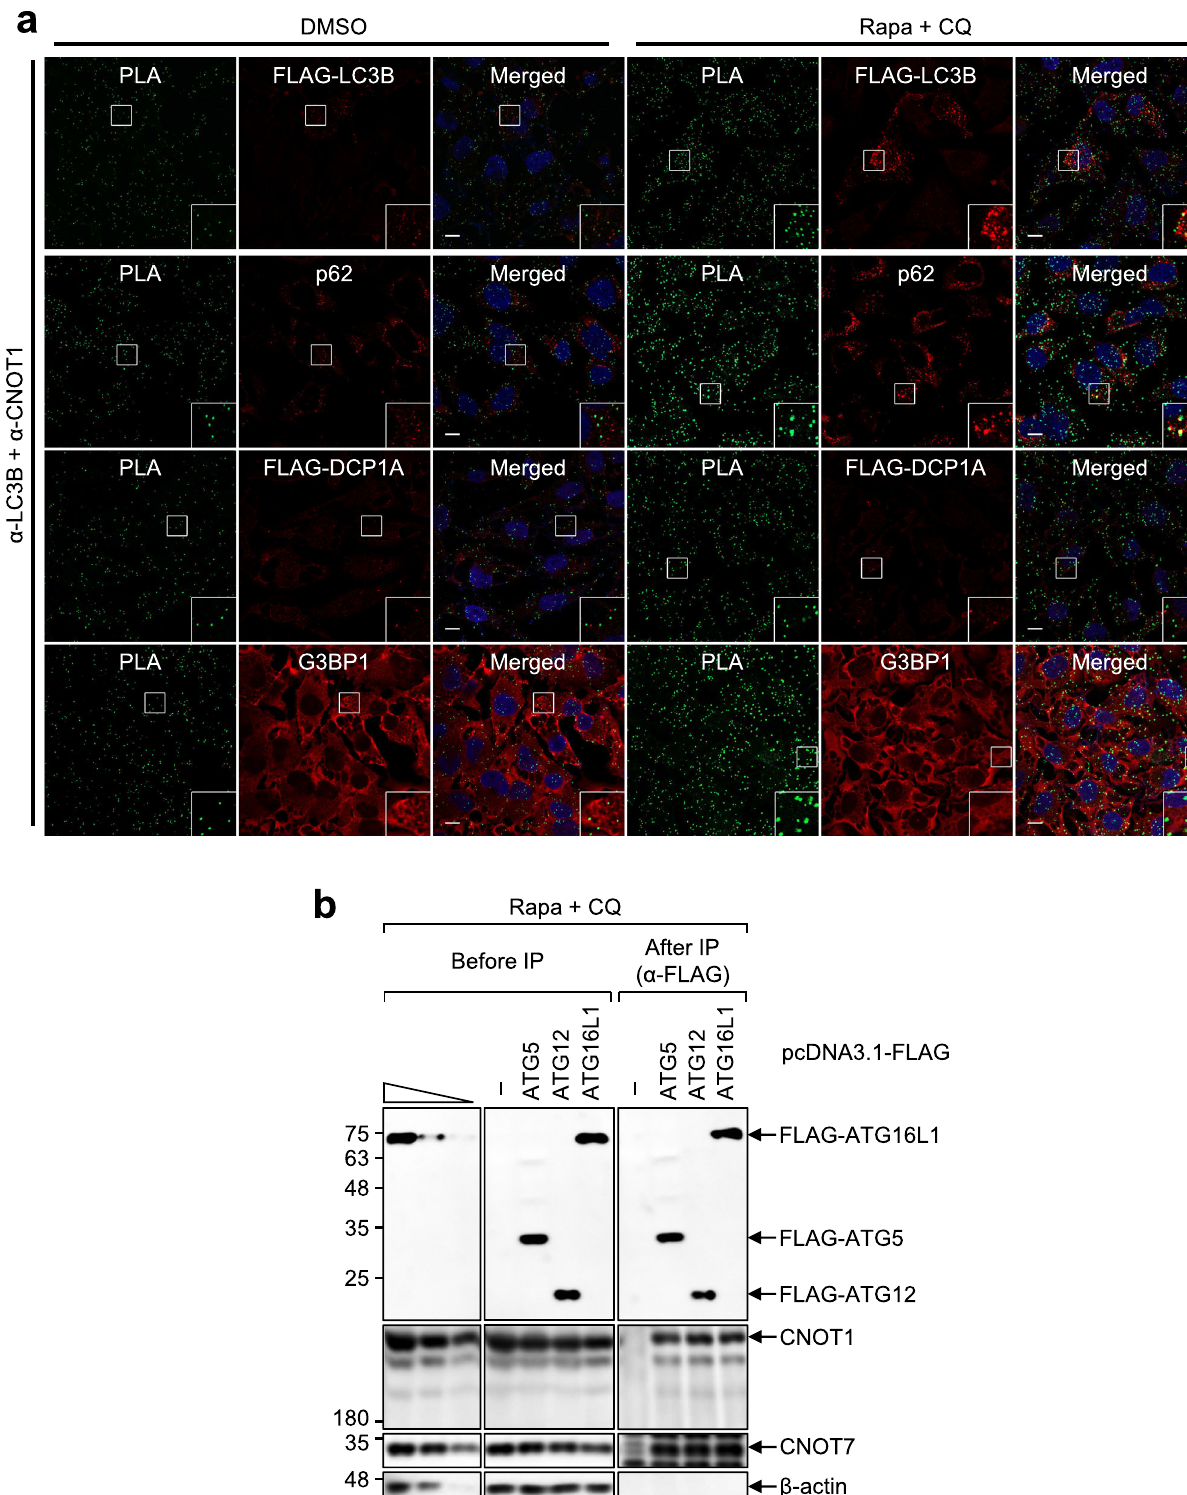
corresponding to ~20kDa above the molecular weight of the immunoprecipitated proteins were excised, and the membrane was soaked in 4mg/ml proteinase K (Roche) for 20min at 37°C with PK buffer [100mM Tris-HCl (pH 7.4), 50mM NaCl, and 10mM EDTA]. After that, PK/7 M urea buffer [100mM Tris-HCl (pH 7.4), 50mM NaCl, 10mM EDTA, and 7 M urea] was added and incubated for 20 min at 37 °C. The soluble fraction was subjected to organic extraction and ethanol precipitation with GlycoBlue TM (Ambion) to precipitate RNA